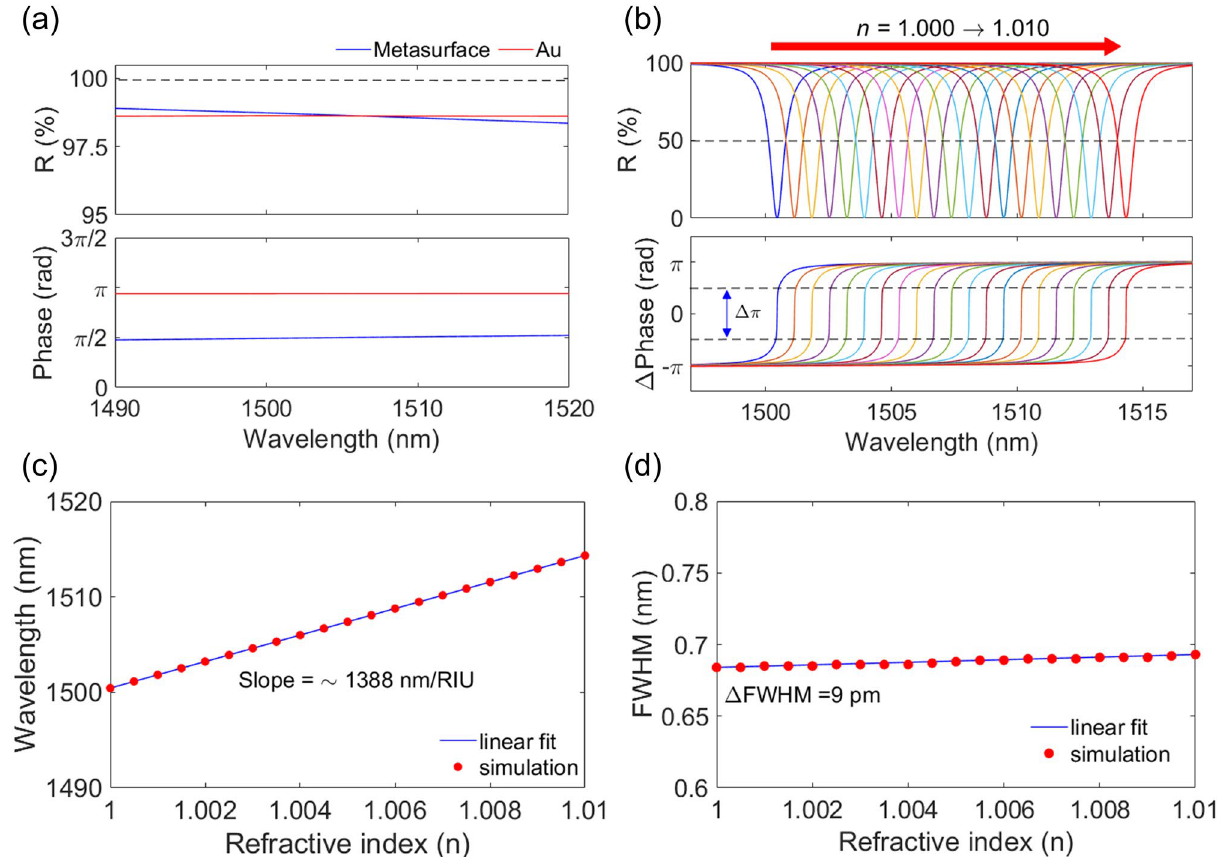
Figure 3. ( a ) Reflectance and phase spectra of the metasurface and Au mirror of a gas MAFP. ( b ) The reflectance and phase change spectra of the gas MAFP cavity with varying the refractive index of gaseous analyte from 1.000 to 1.010 in steps of 5 × 10 −4 . ( c ) The extracted dip position (red circles) of the gas MAFP for each refractive index, and the estimated slope (blue solid line) of ~ 1388 nm/RIU. ( d ) The extracted FWHM (red dots) and the linear fit (blue solid line). The change of FWHM within the refractive index range is 9 pm. All the results are obtained from numerical